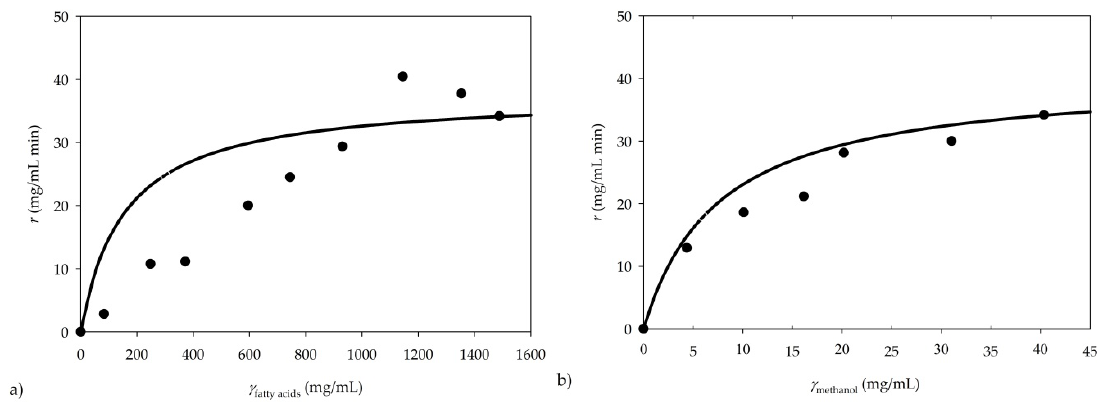
Figure 6. Kinetics of transesterification: dependence of the initial reaction rate on concentration of ( a ) fatty acids and ( b ) methanol.